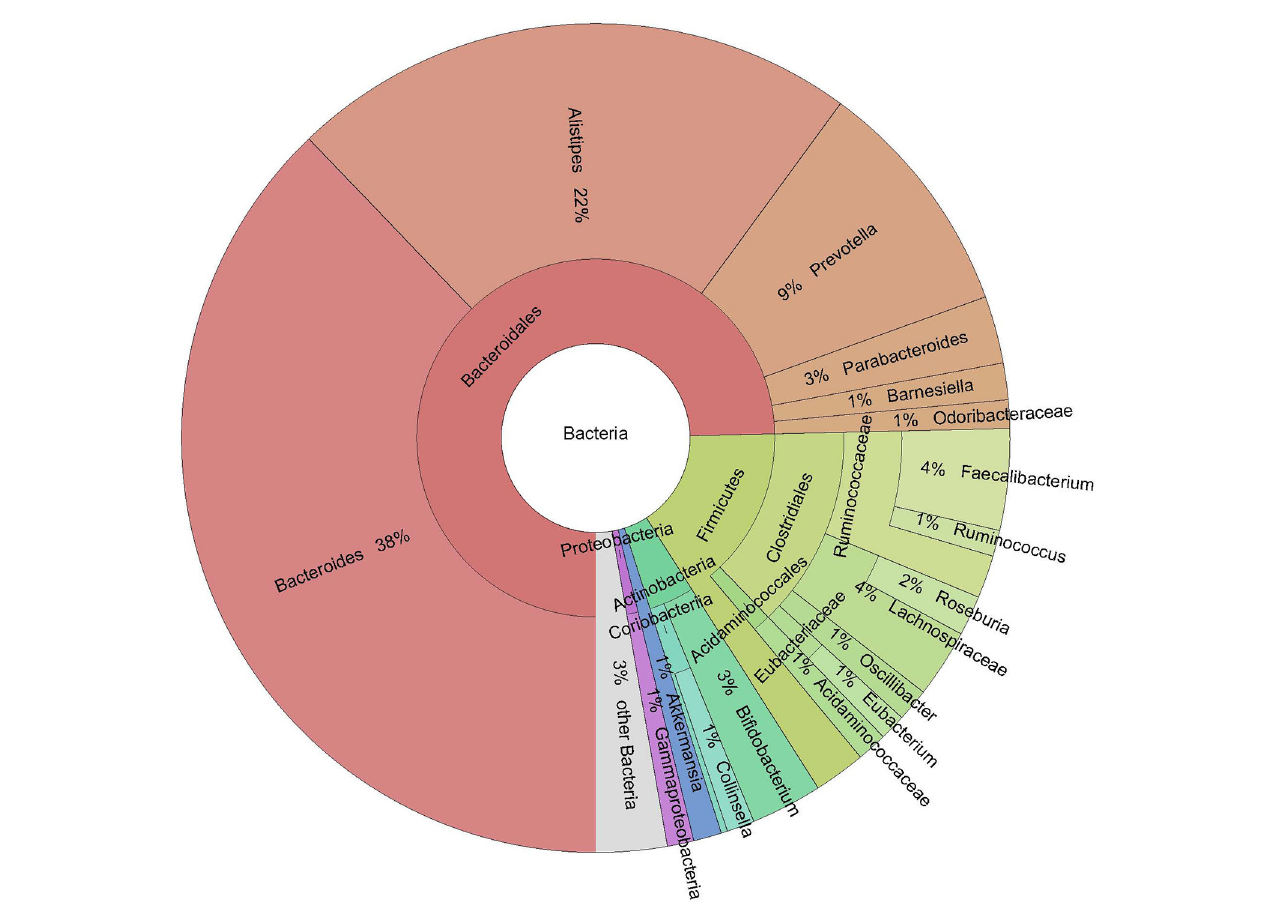
FIGURE1 Krona plot of taxa with a mean abundance higher than 1%.